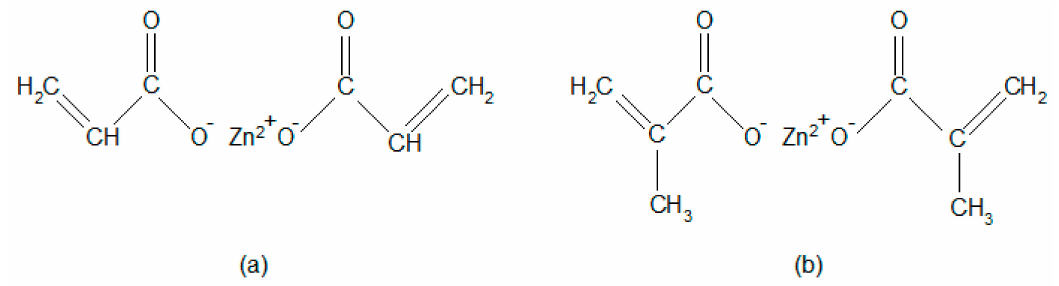
Figure 1. The structural formulas of ( a ) zinc acrylate and ( b ) zinc methacrylate.